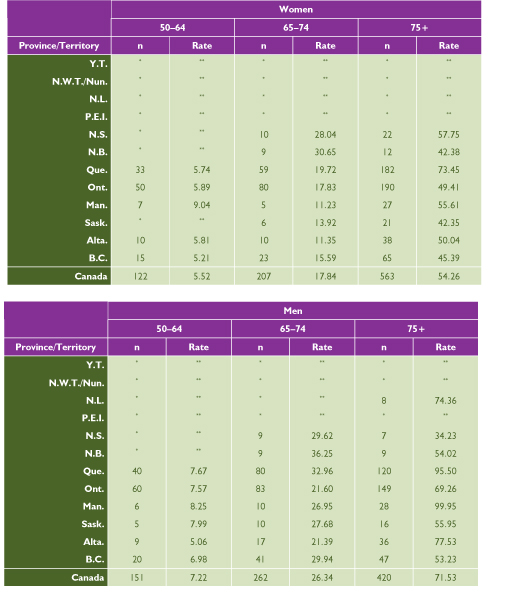
Age and Sex-Specific Intracerebral Haemorrhage Mortality Rates per 100,000 in Canada by Province and Territory, 1997–1998 Source: Health Canada, Canadian Mortality Database